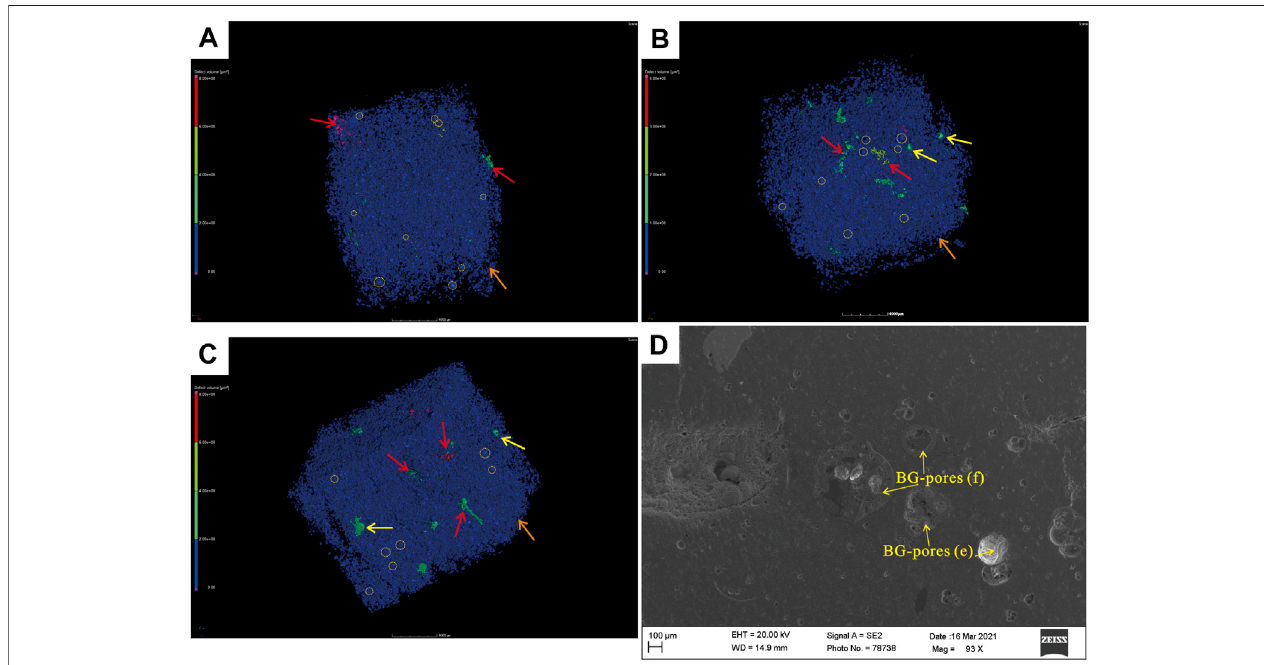
FIGURE6| Microstructureofsedimentsinthenon-GHlayer. (A) SiteW19,126.60mbsf,CTscanimage; (B) SiteW19,127.80mbsf,CTscanimage; (C) SiteW19, 130.15 mbsf, CT scan image; (D) Site W19, 126.60 mbsf, SEM image; red arrows indicate CG-intergranular pores, yellow arrows indicate empty BG-pores (e), orange arrows indicate FG-intergranular pores; yellow dotted circle indicate fi lled BG-pores (f).